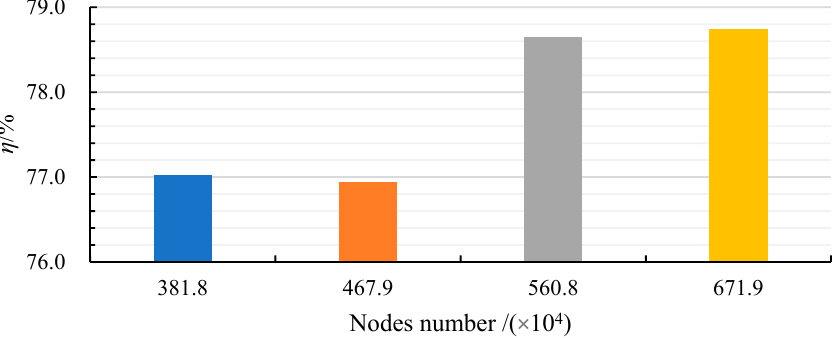
Figure 2. Mesh of axial flow pump device.